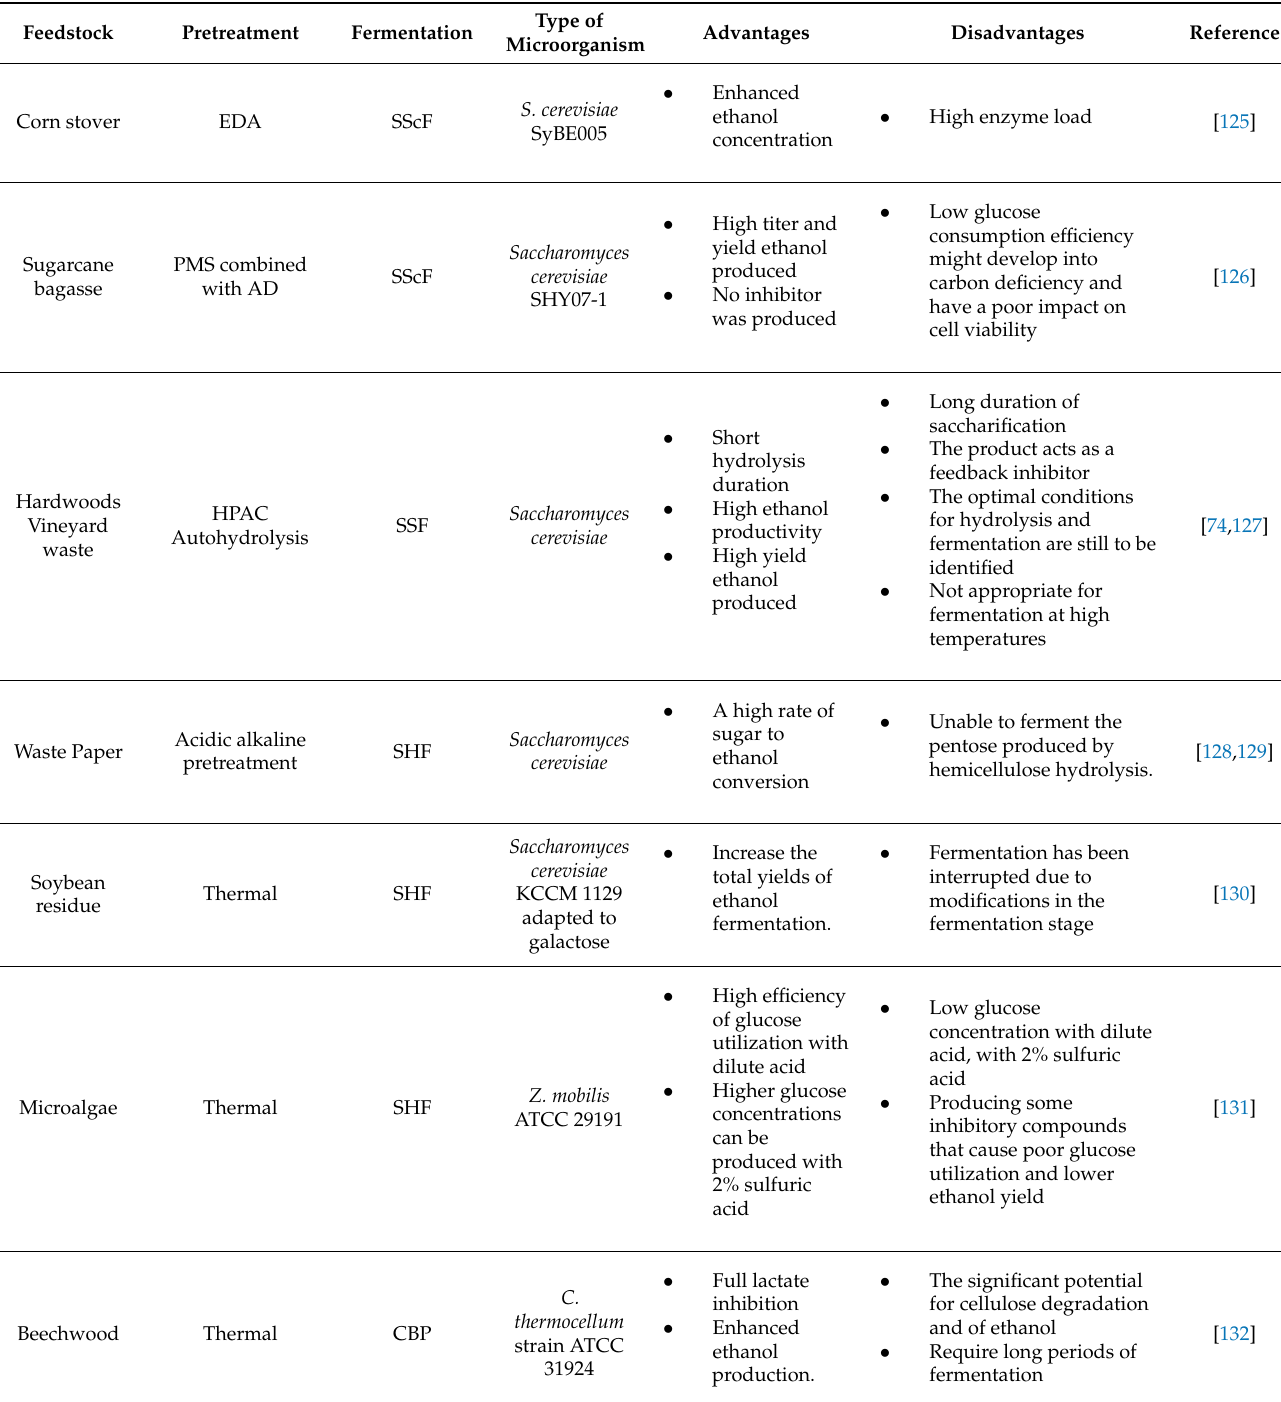
Table 5. The advantages and disadvantages of different types of fermentation and